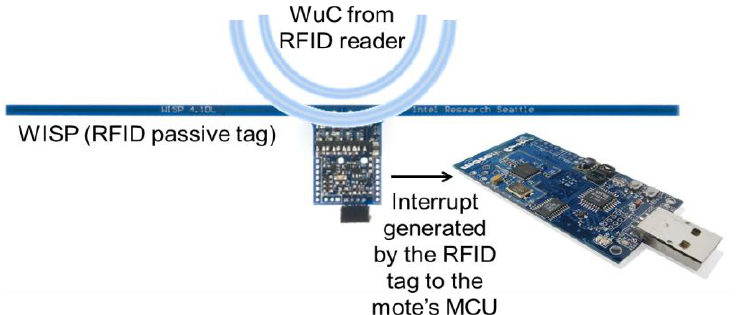
Figure 14. Passive RFID-based WuR